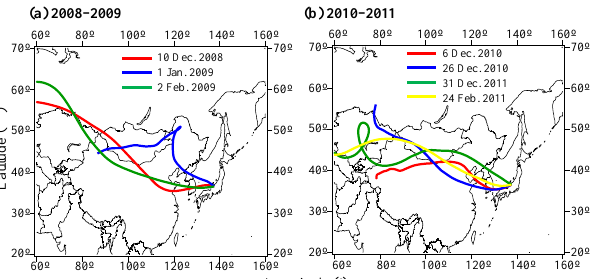
Figure 3. Seven-day airmass back trajectories at a level of 3000ma.s.l. over the Murodo-Daira site in (a) 2008–2009 and (b) 2010–2011. Color lines show the trajectories associated with dust layers as observed by a lidar.